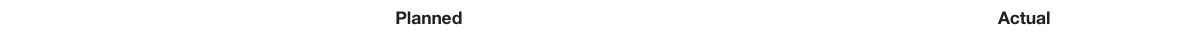
TABLE 1 | Changes made to the methodology used during the beta testing of the CFM patient decision aid.